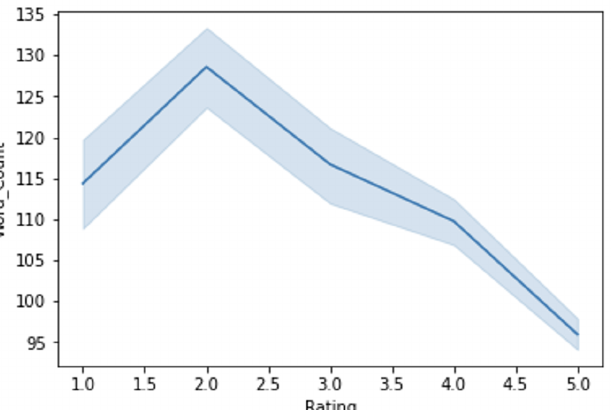
Figure 2. Correlation between the average number of words in the “Review” with the assigned